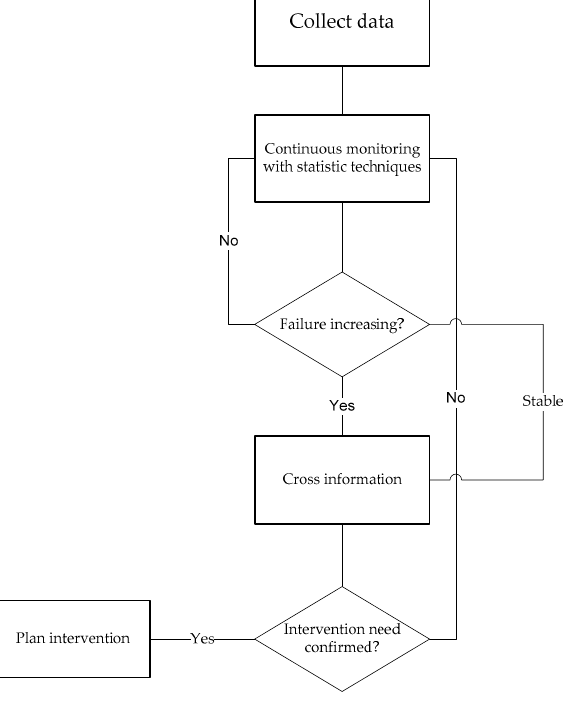
Figure 1. Methodology. Figure 1.